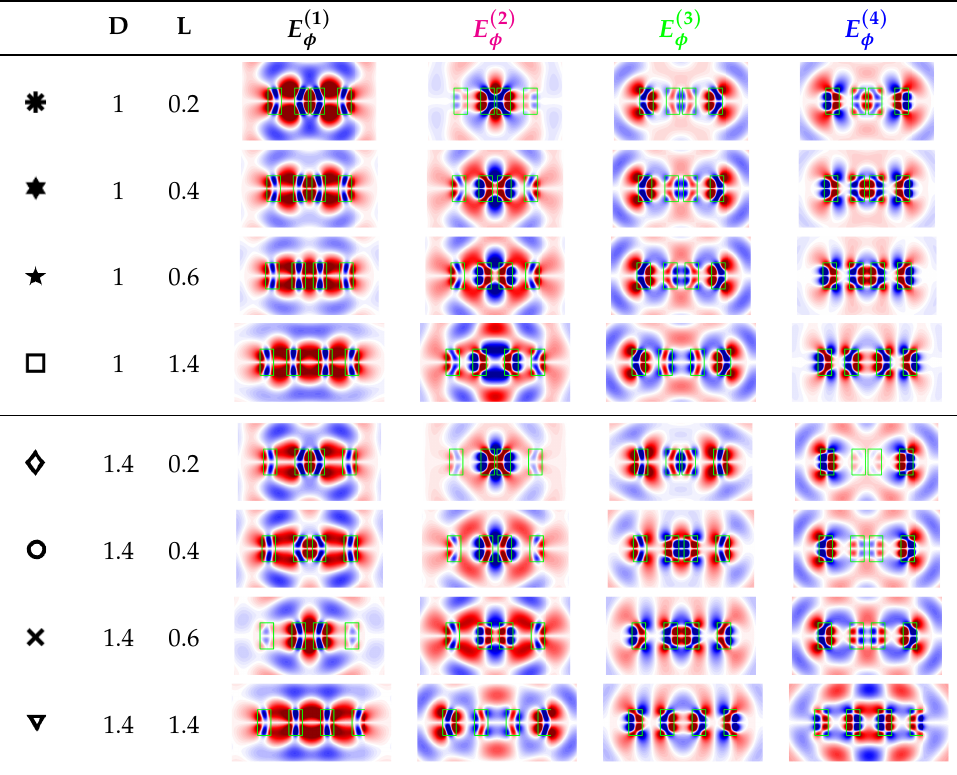
Table 2. E φ component of EM field for symmetric eigenmodes of 4